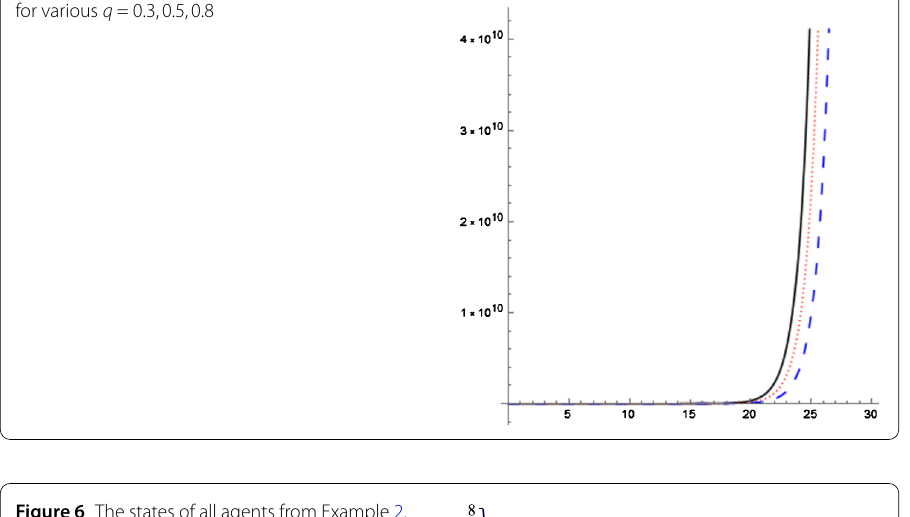
Figure 6 The states of all agents from Example 2. The leader state is drawn in thick black and the states of followers are in